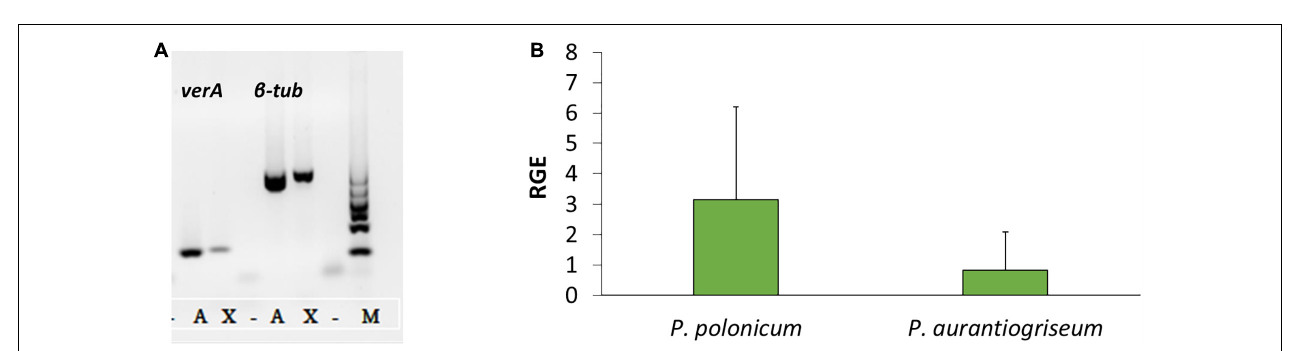
FIGURE 1 | Representation of verrucosidin gene cluster in P. polonicum . Maps were obtained with SnapGene software.